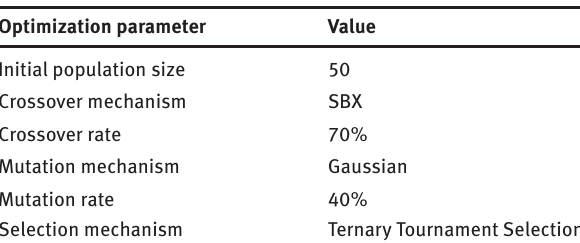
Table 2: The value of parameters used for multi-objective